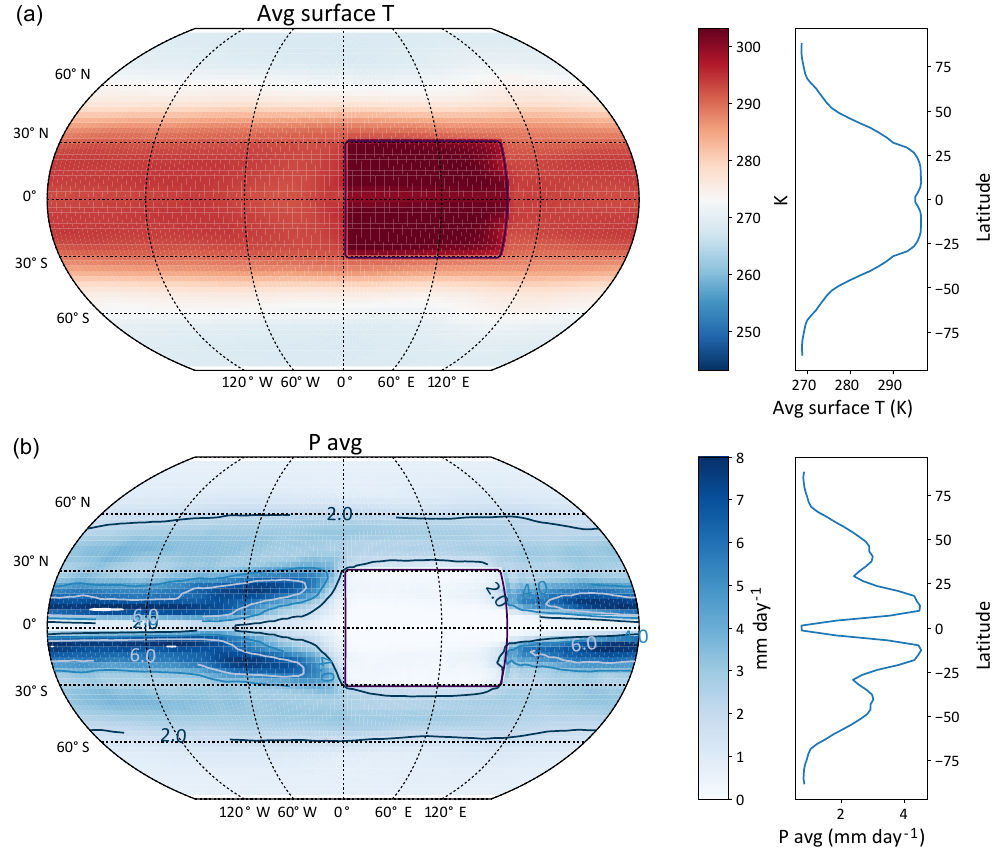
Figure 4. Annually averaged temperature (a) and precipitation (b) , with zonal averages shown in the right-hand panels. This model has an idealized, flat, rectangular continent; clearly visible seasons; and an obliquity of 23 ◦ , and it uses Q fluxes that target zonally averaged AMIP sea surface temperatures derived from Taylor et al. (2000). The ocean has a heat capacity of a 20m mixed-layer depth and the land has a heat capacity equivalent to